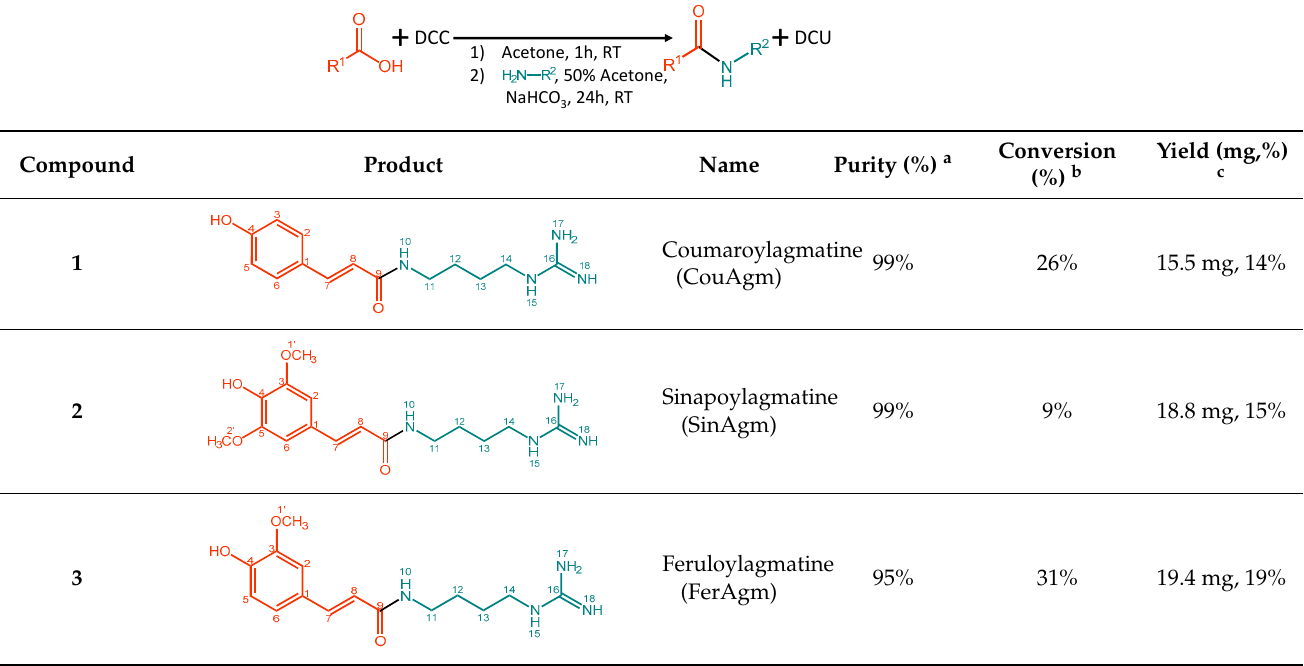
Table 1. Amidation products, conversions, and yields.